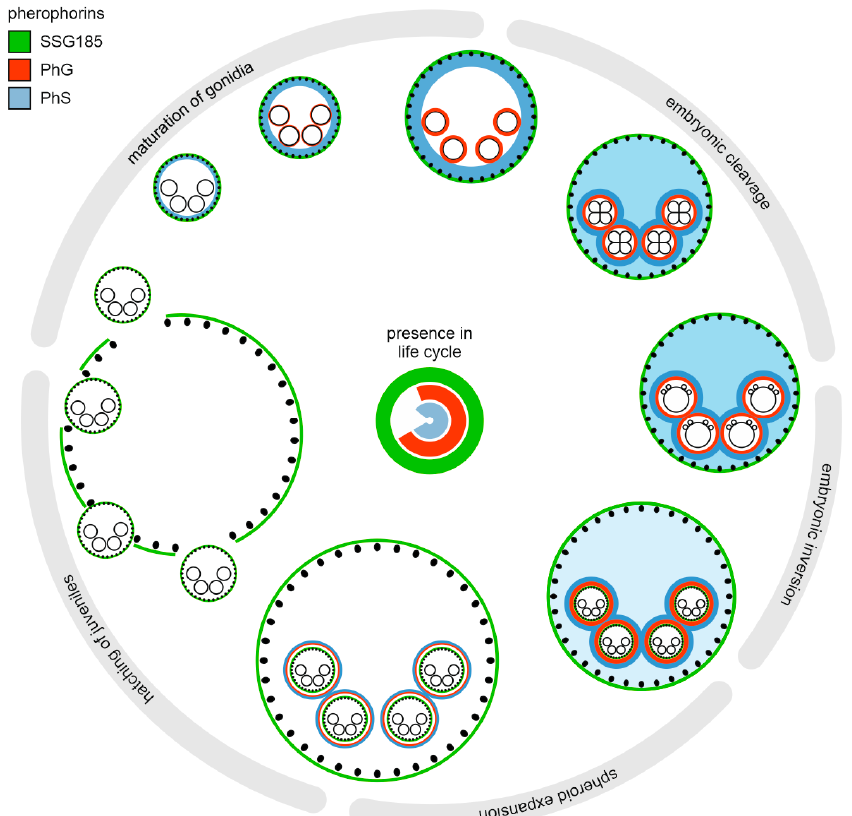
Figure 11. Schematic representation of the localization of three pherophorins, PhG, SSG185 and PhS, in the life cycle of V. carteri . The localization of three pherophorins, PhG, SSG185 and PhS, is known throughout the vegetative life cycle of V. carteri , which lasts 48 h under standardized laboratory conditions. The ECM synthesis begins after completion of cell divisions and embryonic inversion. At about the beginning of ECM biosynthesis, pherophorin SSG185 (green) is synthesized by somatic cells and can be detected in the boundary zone and at the flagellar hillocks. SSG185 remains detectable there throughout the life cycle and it can therefore be found in both the parent and the post-inversion juveniles. In the maturation phase of gonidia, the maturing gonidia start synthesis of PhG (red), which is subsequently detectable in the gonidial vesicle. Shortly before hatching of the juveniles, the gonidial vesicle is enzymatically degraded and PhG is no longer detectable. PhS (blue) is initially secreted into the CZ of the somatic cells, where it does not remain [19]. As ontogeny progresses, it increasingly diffuses into the inner ECM layers of the spheroid and it eventually accumulates around the gonidial vesicle [19]. During hatching of the juveniles, PhS is